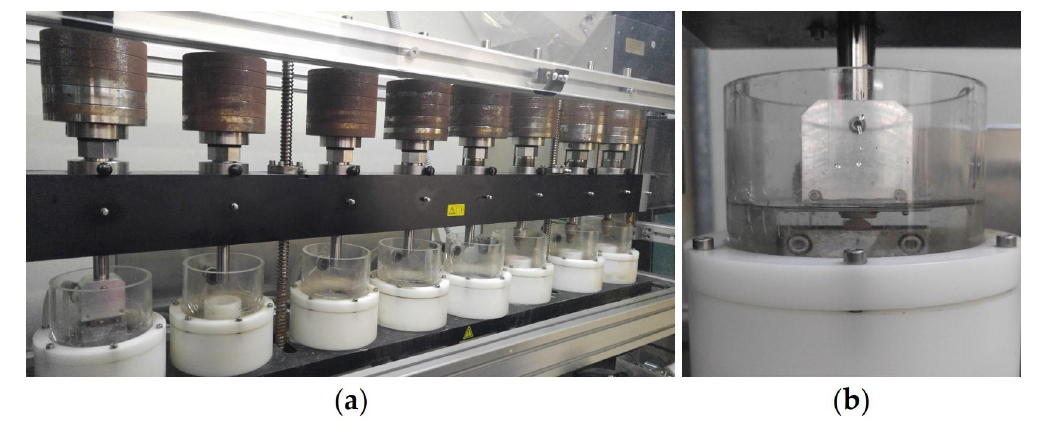
Figure 2. Set-up wear simulation. ( a ) Chewing simulator; ( b ) Specimens fixed in test